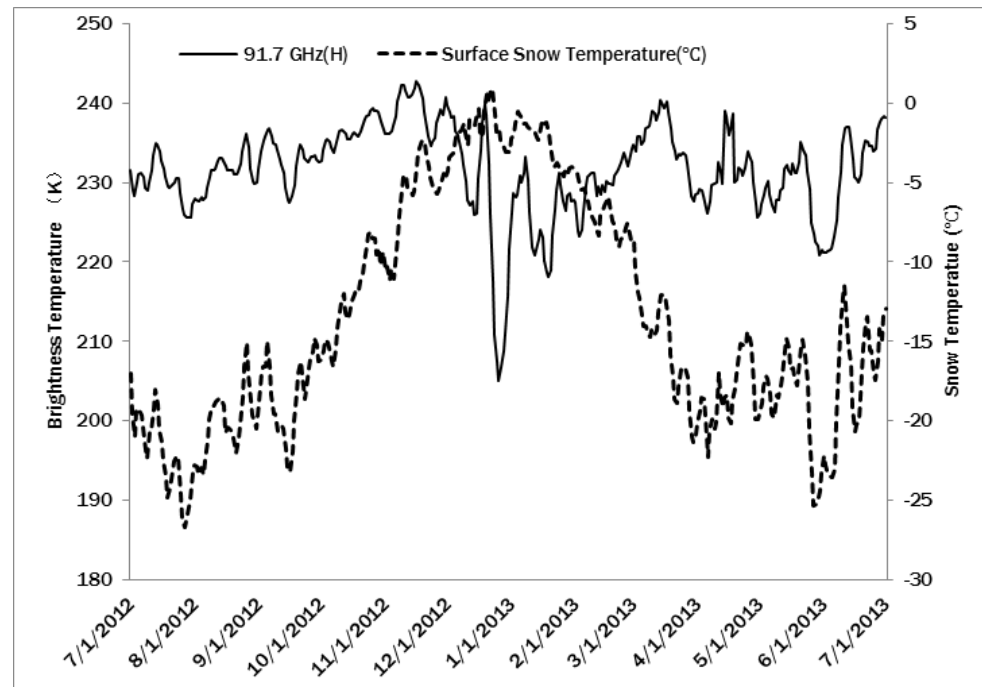
Figure 9. Comparison of the surface snow temperature (five days moving average value) in the daytime at Installation Point 1 (right axis) and the data of SSMI/S microwave radiometer (left axis).